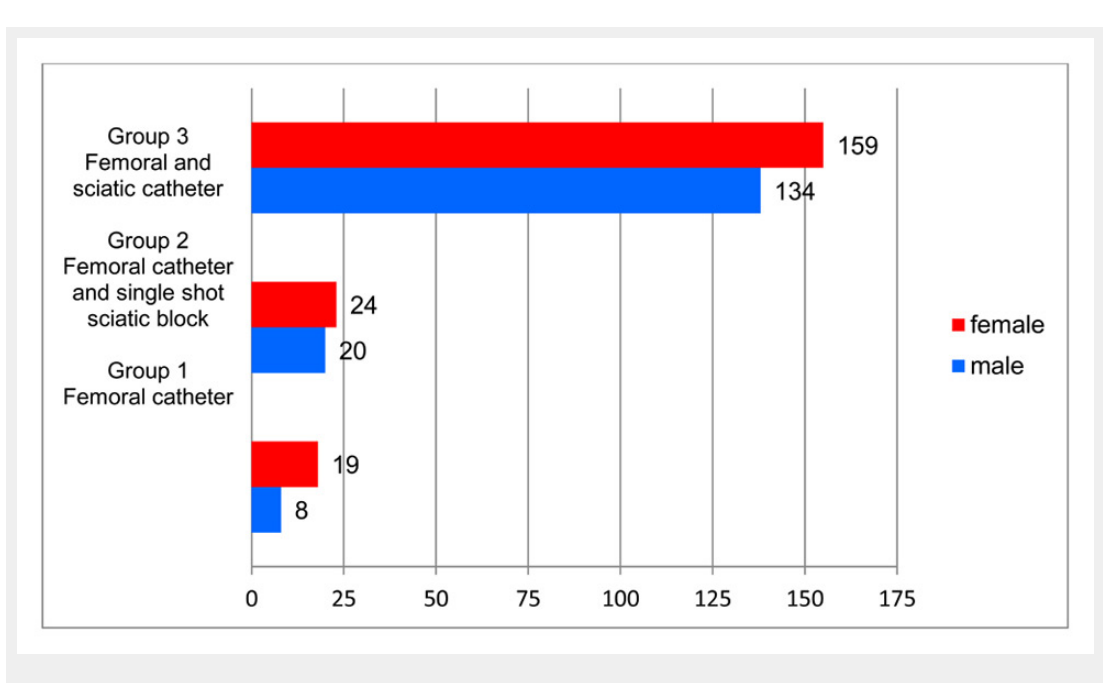
Figure 1 Group distribution.